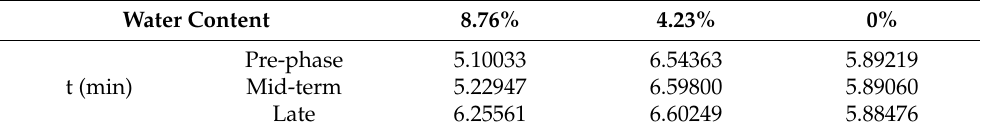
Table 2. Variation law of temperature reduction of coal samples with a different water content from 4 ◦ C to − 10 ◦ C (60